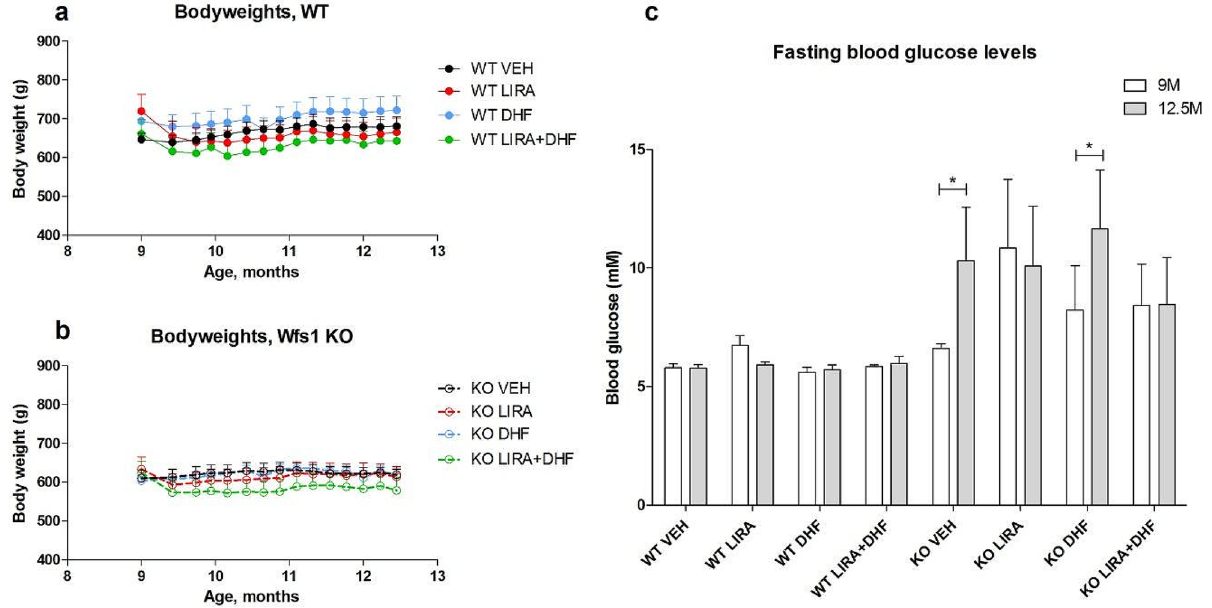
Figure 1. Body weight change and fasting blood glucose levels during the experiment. Liraglutide (LIRA) and liraglutide in combination with 7,8-DHF (DHF) induced a slight decrease of bodyweight at the beginning of experiment in both genotypes ( a , b ). Animals were fasted for 3 h before measurement of blood glucose levels. Fasting blood glucose levels were not changed during the experiment in WT animals regardless of the treatment ( c ). As expected, blood glucose levels were elevated in Wfs1 KO animals receiving vehicle treatment ( c ), treatment with 7,8-DHF did not prevent such an increase. In contrast, treatment with liraglutide alone or in combination with 7,8-DHF prevented development of fasting hyperglycemia in Wfs1 KO animals ( c ). The data were compared using repeated measures ANOVA followed by Bonferroni post hoc tests; *p < 0.05. The data are presented as the mean ± SEM, n = 5–8 per